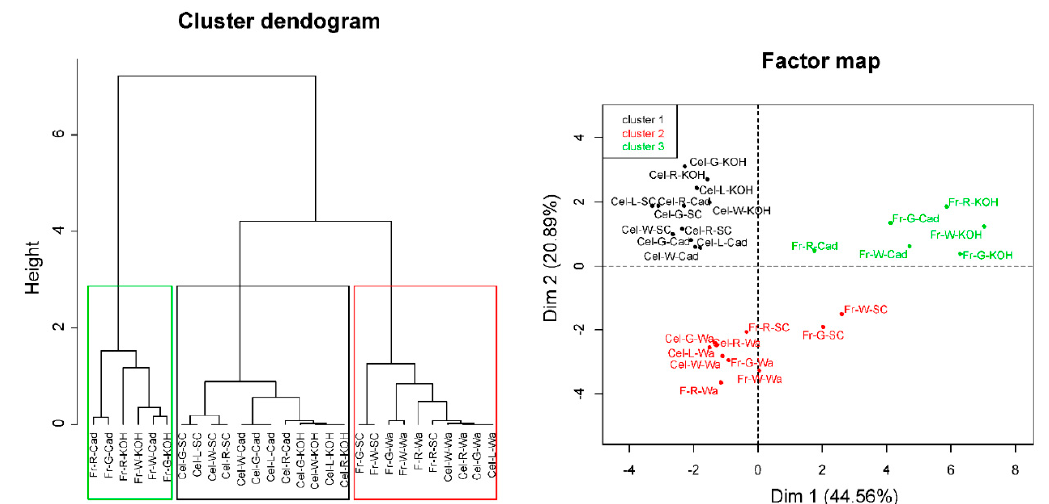
Figure 9. Hierarchical clustering of carbohydrate microarray data. Cluster dendogram based on Euclidean distances ( left ) and the corresponding individual factor map ( right ) of the different cell wall samples. Fr: fruit; Cel: callus culture; G: green stage; W: white stage; R: red stage; Wa: water fraction; SC: sodium carbonate fraction; KOH: 4M KOH fraction, Cad: cadoxen fraction.